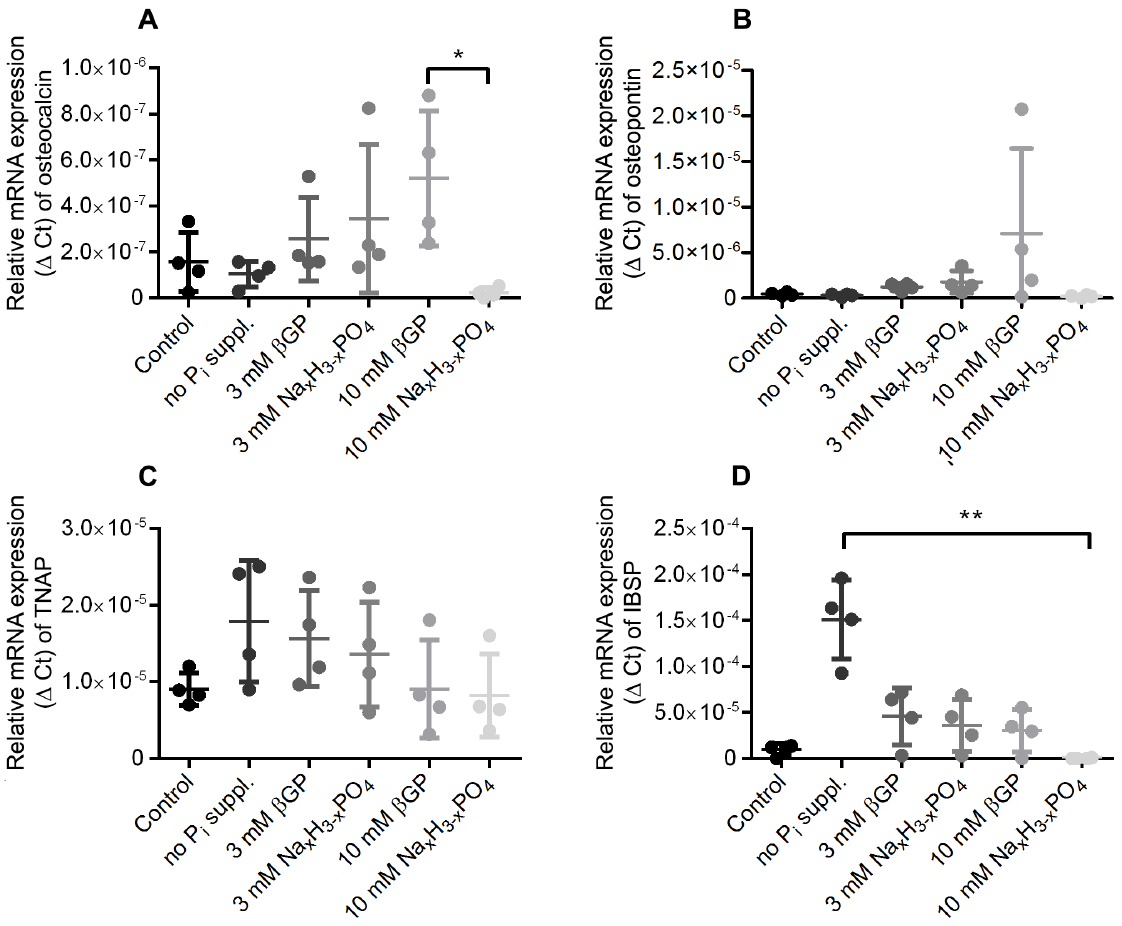
Figure 3. mRNA expression levels of osteogenic marker genes. mRNA expression levels of osteocalcin, osteopontin, TNAP and IBSP after 28 days of osteogenic differentiation depending on the phosphate source. The relative mRNA expression ( D Ct) is plotted against the phosphate supplementation for five different genes involved in the formation of bone (n=4). Plotted as mean 6 SD.